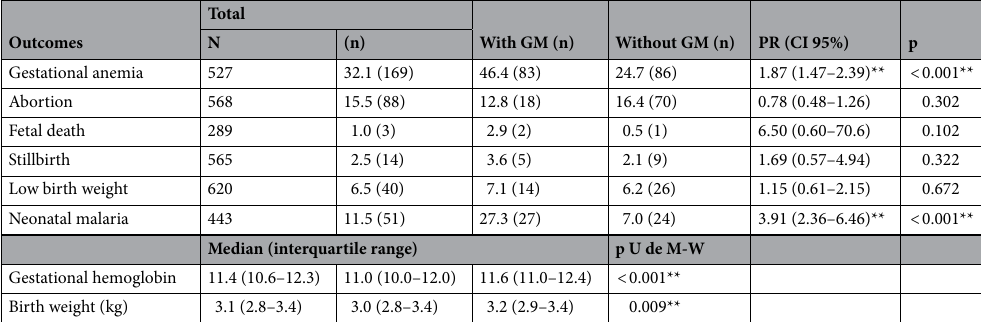
Table 4. Comparison of maternal, fetal, and neonatal outcomes in pregnant women with and without malaria. PR Prevalence ratio, 95% CI 95% confidence interval, M–W Mann–Whitney. *p < 0.05. **p <